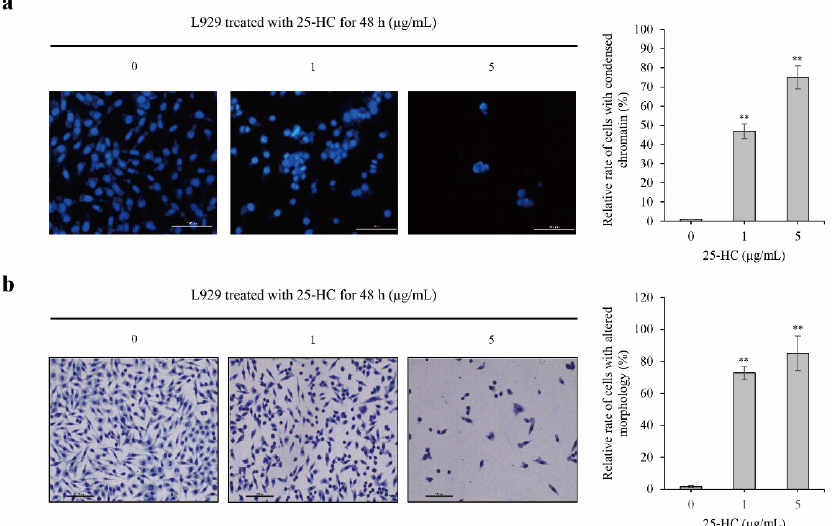
Figure 3. 25-HC not only decreased the number of cells, but also increased the number of L929 cells with apoptotic characteristics, such as condensed chromatin and altered morphologies. L929 cells were cultured on 8-well chamber slides and treated with 1 and 5 µ g/mL 25-HC for 48 h. DAPI ( a ) and